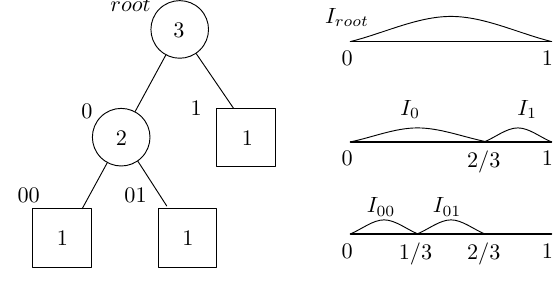
Figure 1. Binary tree and its